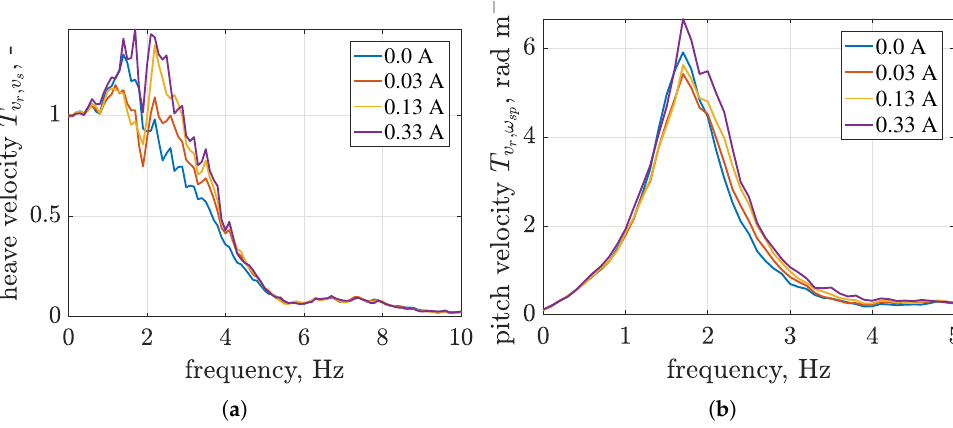
Figure 10. Transmissibility characteristics of vehicle body dynamics for passive suspension and constant vehicle longitudinal velocity equal to 5 ms − 1 : ( a ) heave velocity, ( b ) pitch